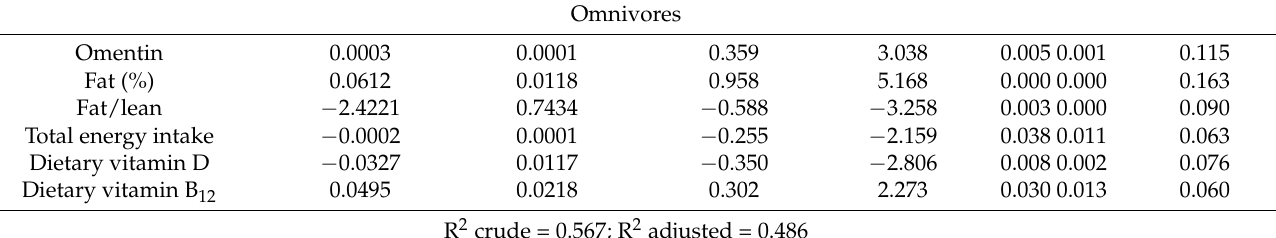
Table 6. Multivariate regressions of irisin with independent variables in the groups of vegetarians and omnivores.